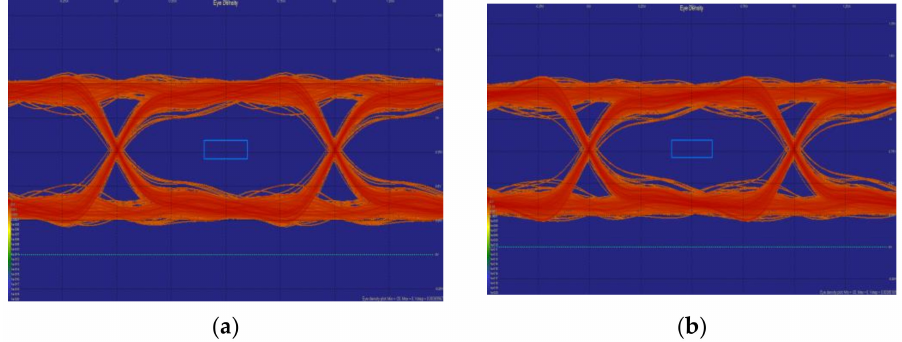
Figure 6. ( a ) 2.133 Gbps data rate channel with no defect ( b ) data channel with crack in solder ball. Figures 7 and 8 show PRBS data eye for data rate of 2.666 Gbps and 3.2 Gbps, respec- tively. As the data rate increases the data eye becomes more closed due to crack in solder ball. PRBS signal with higher data rate contains higher frequencies and attenuation of these high frequencies due to crack causes more data eye degradation.